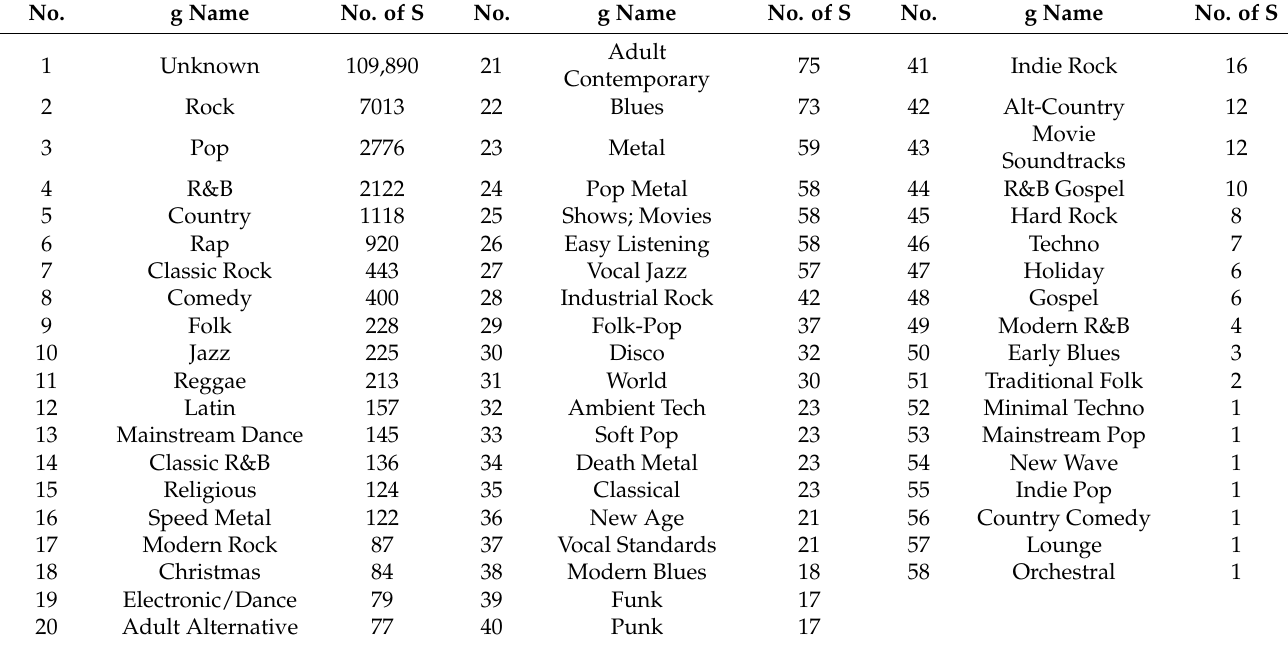
Table 7. Genre name in R2-Yahoo Music dataset and number of songs per genre.